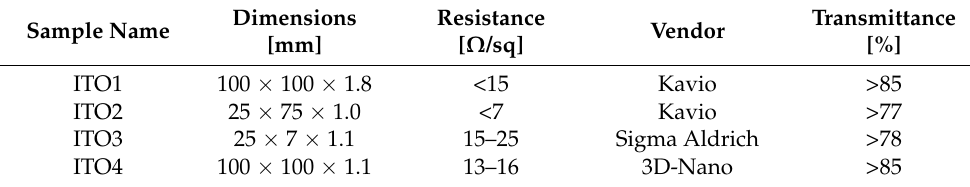
Table 1. Properties of glass substrates coated with